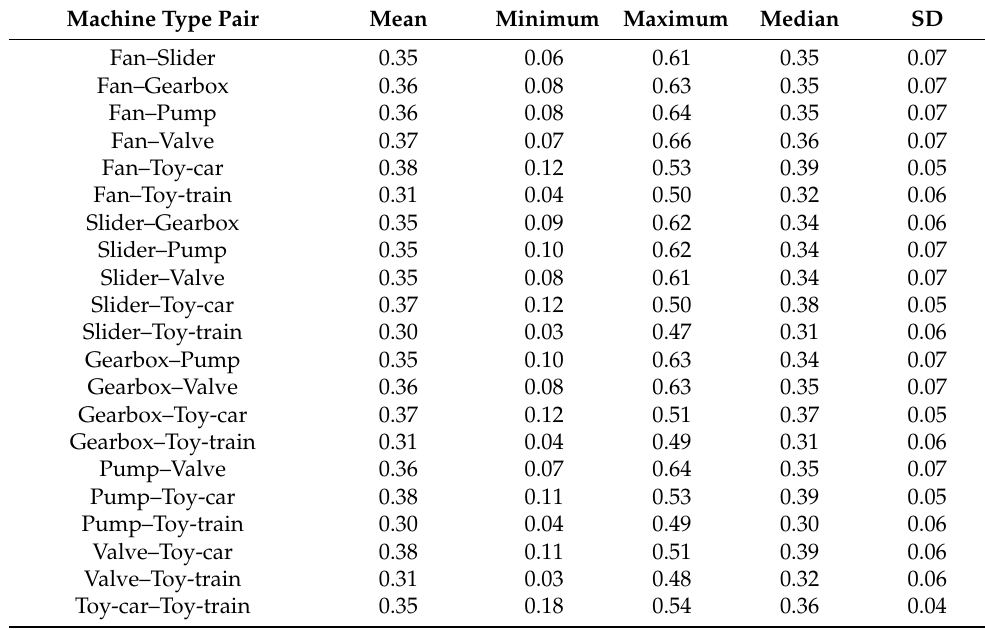
Table 3. Statistical quantities of interclass similarity obtained using SSIM measure calculated from the full